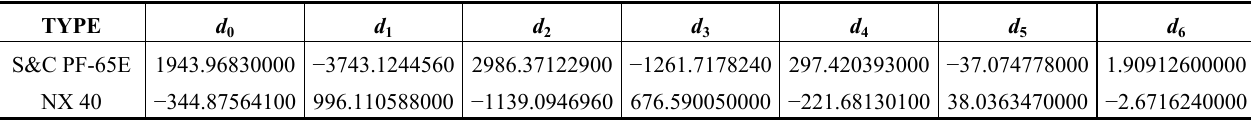
Coefficients of S&C PF-65E and NX40 power fuse total clearing time-current Table A3. d i characteristic